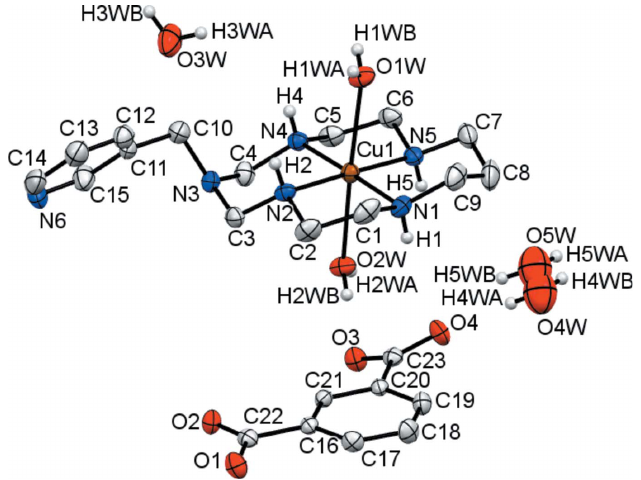
Figure 2 View of the asymmetric unit of (II), showing the atom-labelling scheme, with displacement ellipsoids drawn at the 30% probability level. H atoms attached to carbon atoms have been omitted for clarity.